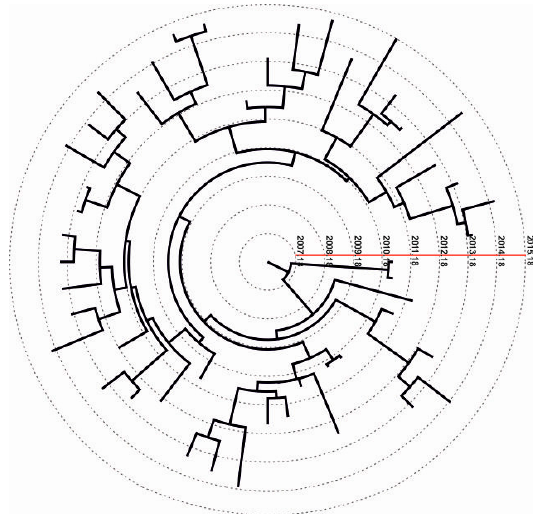
Figure 1. Example of a dated phylogeny (K103N) for one of the five major local transmission networks (LTNs) with resistance. The red line indicates years and the root corresponds to the origin of the K103N sub-epidemic. Dotted lines indicate middle time points across the tree.